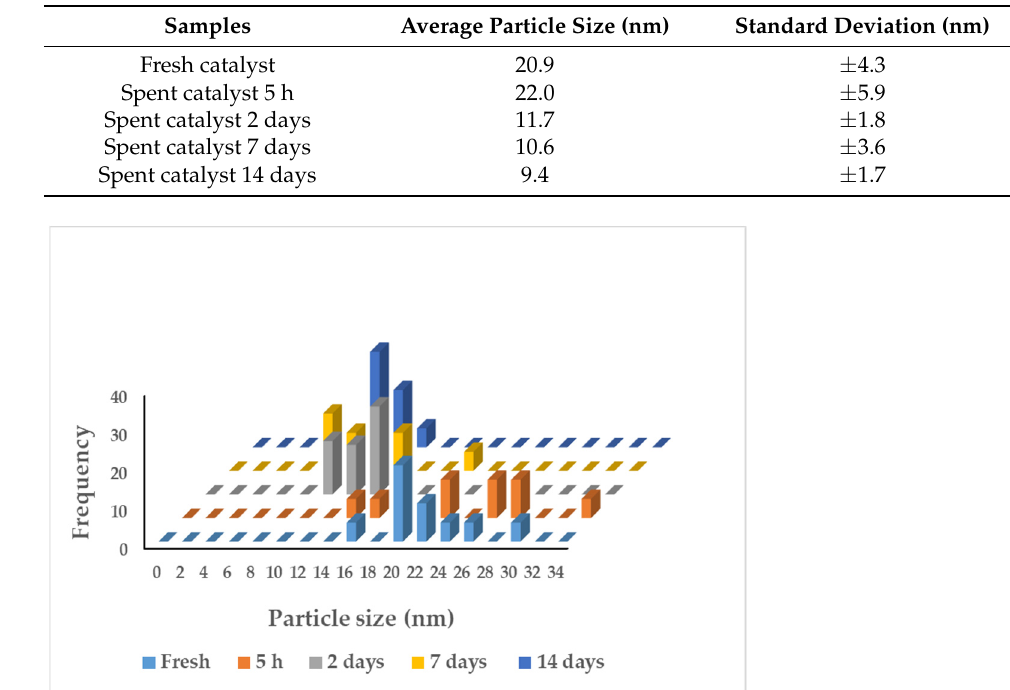
Figure 3. TEM images of ( a ) fresh and spent catalysts after reaction durations of ( b ) 5 h ( c ) 2 days ( d ) 7 days and ( e ) 14 days. Table 5. Average particle size of catalyst samples.